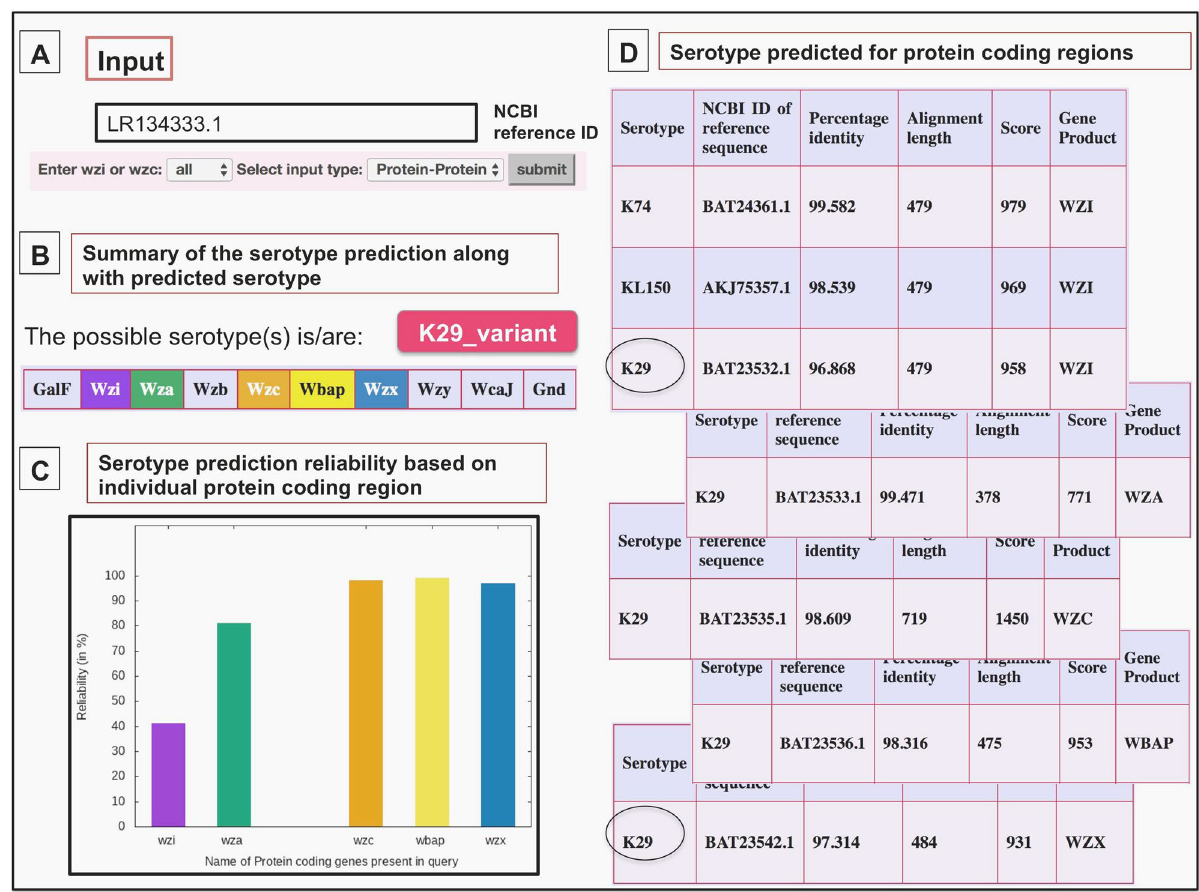
Figure 4. Serotype prediction example considering protein coding regions of a query sequence whose serotype is unknown (NCBI accession number LR134333.1). ( A ) In the input box, the NCBI accession ID is provided along with “all” and “protein–protein” options. ( B ) The serotype prediction summarized in the result page, wherein, the predicted serotype and coding regions identified are listed. The proteins present in the query sequence and used in serotyping are given in the color-coded box. The user can get the antigen details by clicking the serotype button. ( C ) A graphical representation of the reliability of serotype prediction with respect to individual protein coding sequences. ( D ) Tables (stacked) summarizing the prediction with respect to individual protein sequences. Note that after reducing the cutoff to 95%, the encircled serotype is predicted from Wzi and Wzx